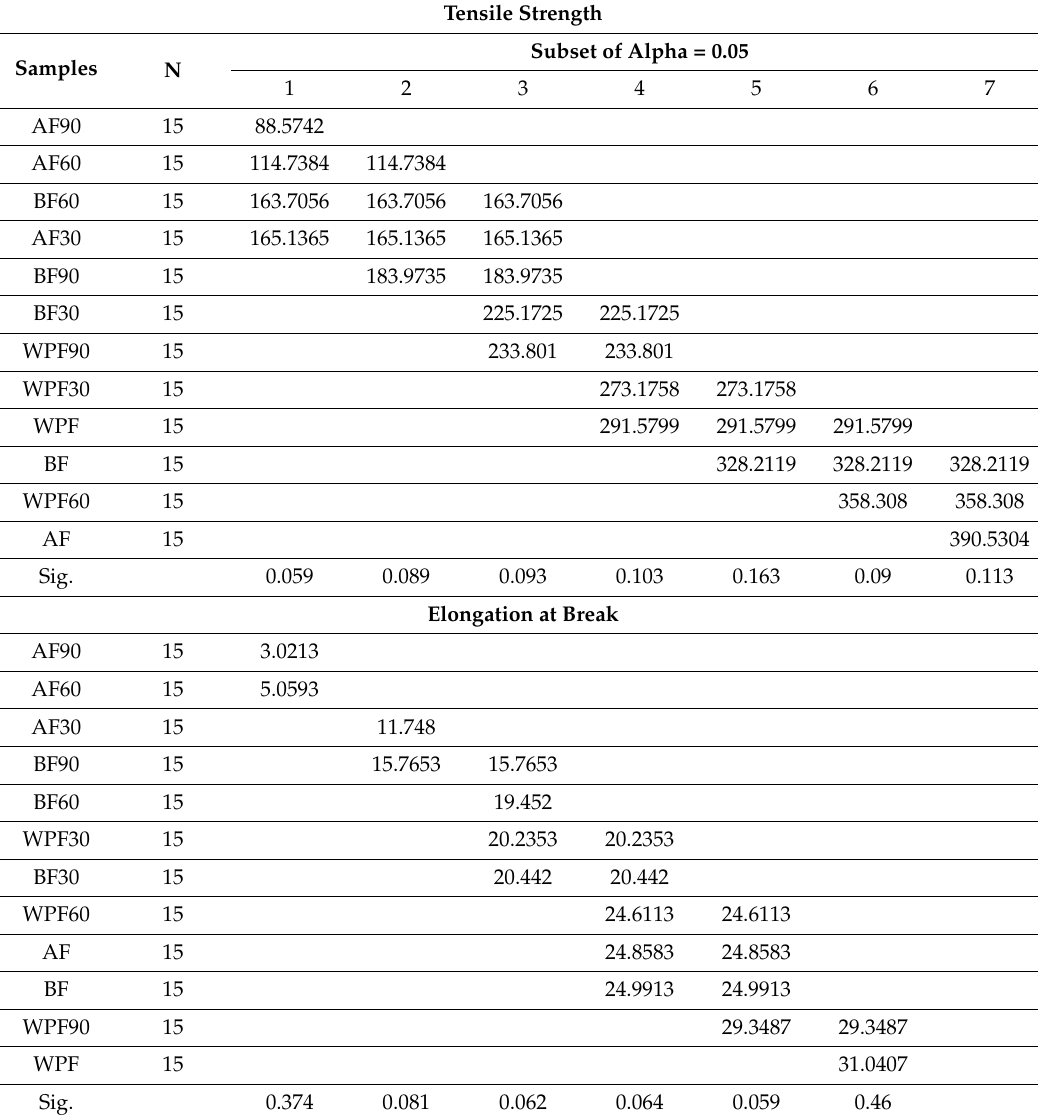
Table 2. Analyses of the mean tensile strength and elongation at break for windmill palm fiber, before and after